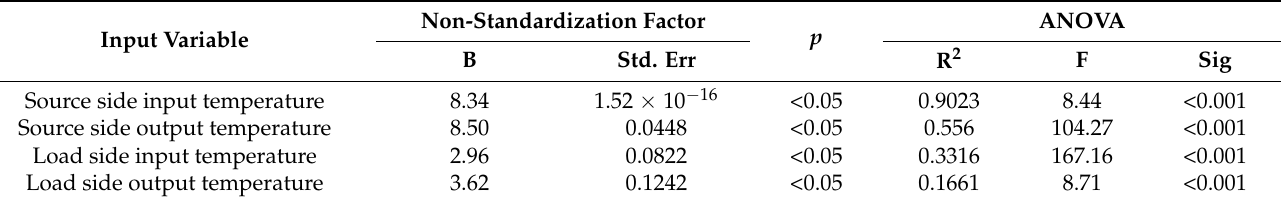
Table 3. Analysis of input